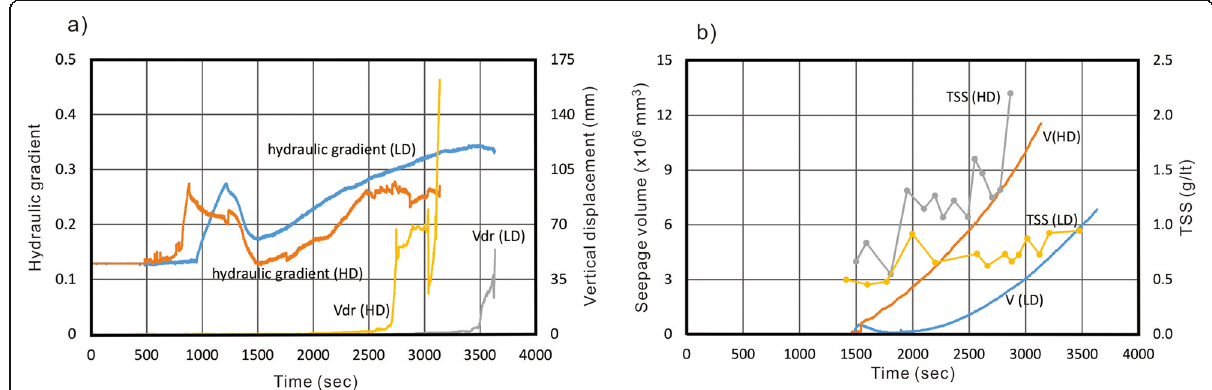
Fig. 6 Time series data of hydraulic gradient, vertical displacement, seepage volume and TSS for the sample S4568 at a Low dam height (LD) (200 mm) and High dam height (HD) (250 mm). a Hydraulic gradient and vertical displacement; b Seepage volume and